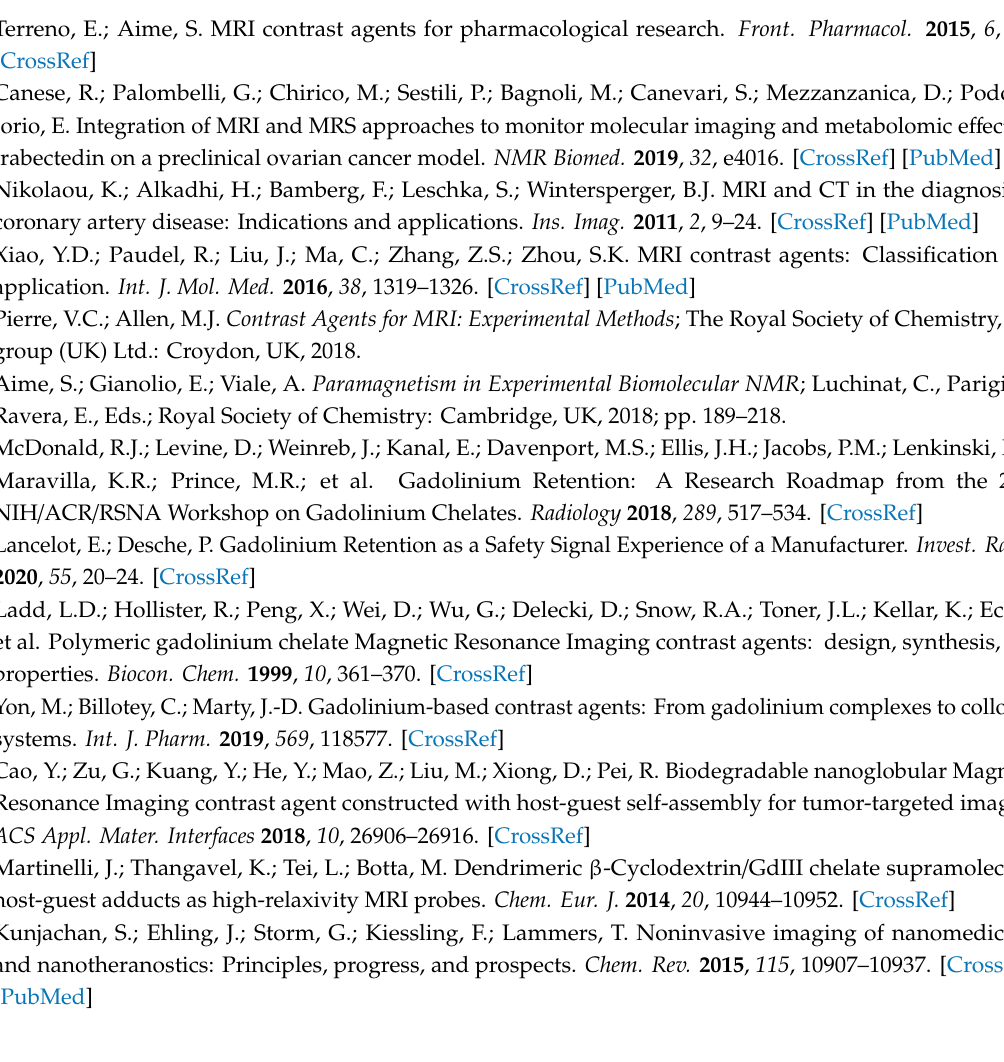
Figure S1: Chromatograms and ESI spectra of DOTA-PEG8-(FY)3 and DTPA-PEG8-(FY)3. Figure S2: Fluorescence emission spectra of DTPA(Gd)-PEG8-(FY)3 excited at λ ex = 276 nm in 0.1-2.5 mg / mL concentration range. Figure S3: FTIR spectra of DTPA-PEG8-(FY)3 as free base (in black) and as Gd-complex (in